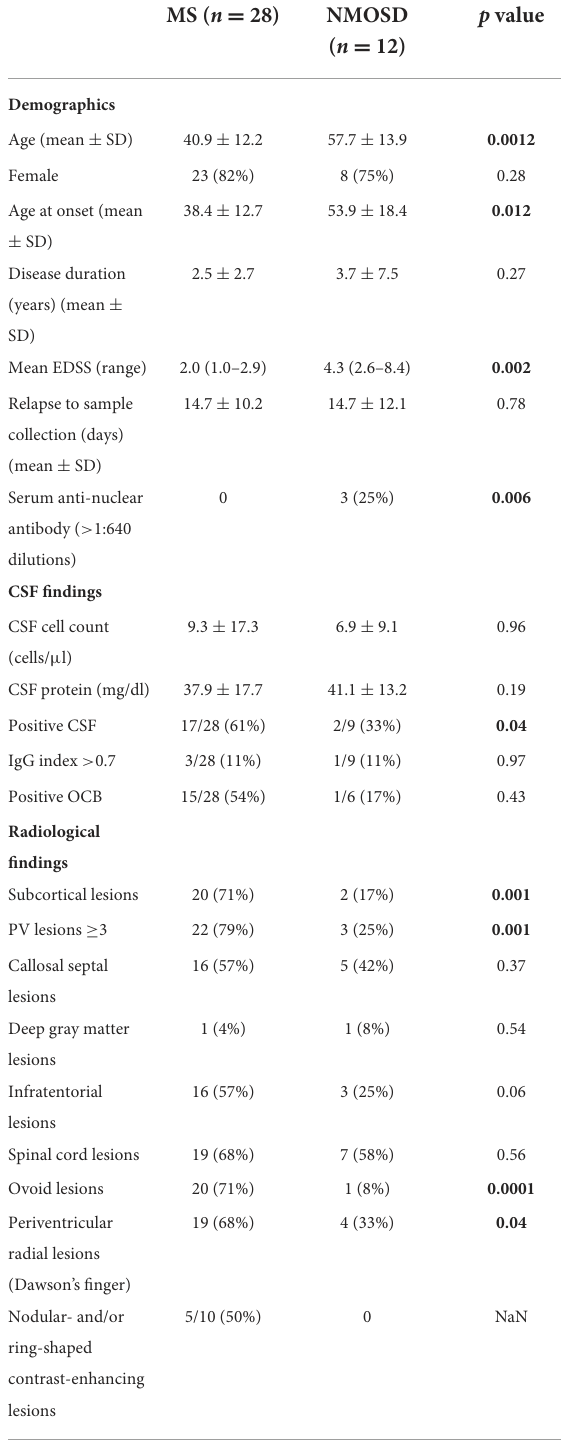
TABLE 1 Demographic characteristics, laboratory and radiological